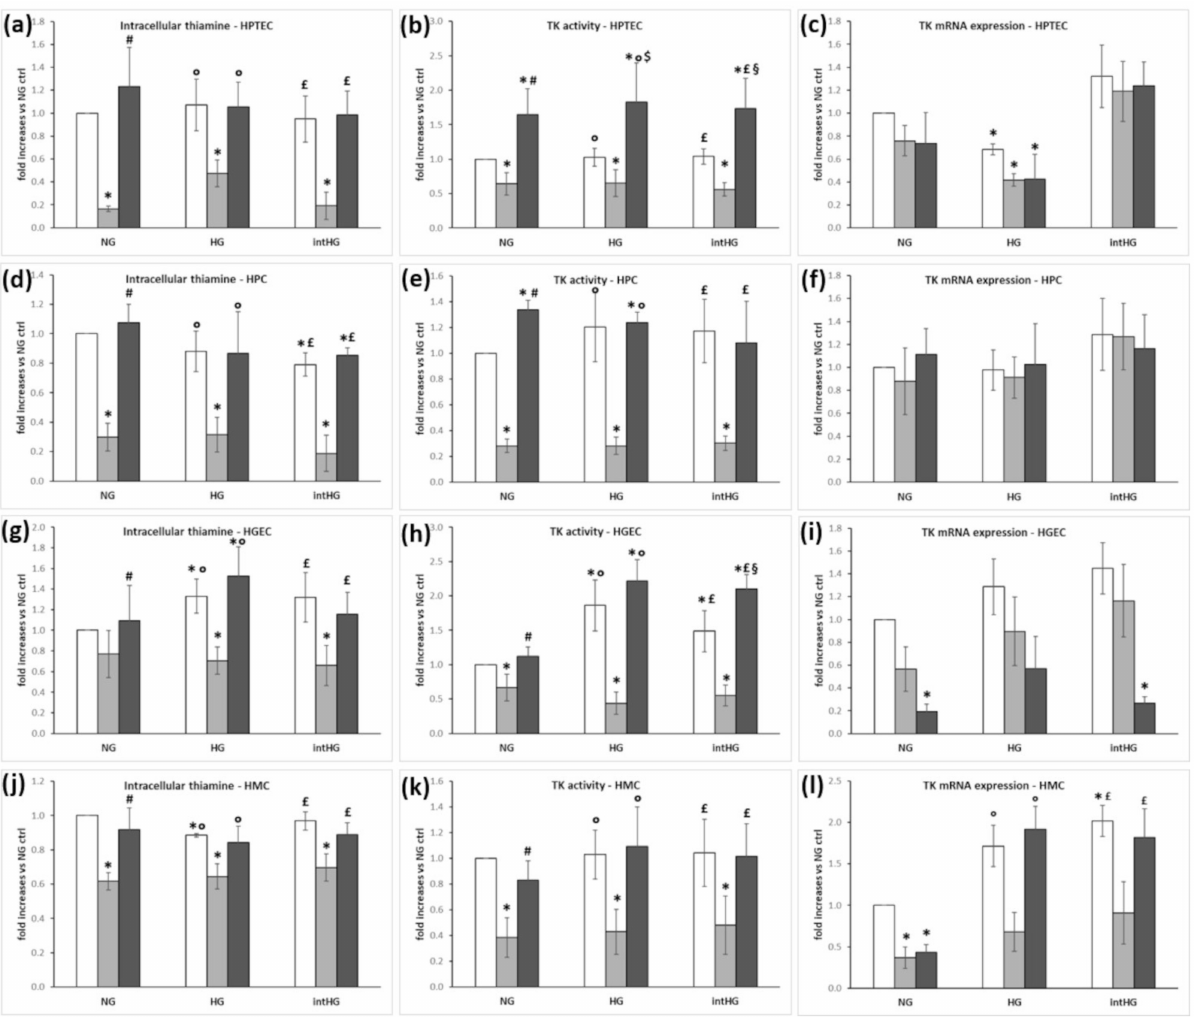
Figure 6. Intracellular thiamine concentration, TK activity, and TK mRNA expression in renal cells under different experimental conditions. ( a ) Intracellular thiamine, ( b ) TK activity, and ( c ) TK mRNA expression in HPTEC; ( d ) intracellular thiamine, ( e ) TK activity, and ( f ) TK mRNA expression in HPC; ( g ) intracellular thiamine, ( h ) TK activity, and ( i ) TK mRNA expression in HGEC; ( j ) intracellular thiamine, ( k ) TK activity, and ( l ) TK mRNA expression in HMC. White bars: physiological thiamine concentrations (ctrl); light grey bars: thiamine-deficient medium (TD); dark grey bars: high thiamine concentrations (HT). NG = physiological glucose concentrations; HG = high glucose concentrations; intHG = intermittent high glucose concentrations. Mean of 5 experiments ± SD. * p < 0.05 vs. NG ctrl; # p < 0.05 vs. NG TD; ◦ p < 0.05 vs. HG TD; £ p < 0.05 vs. intHG